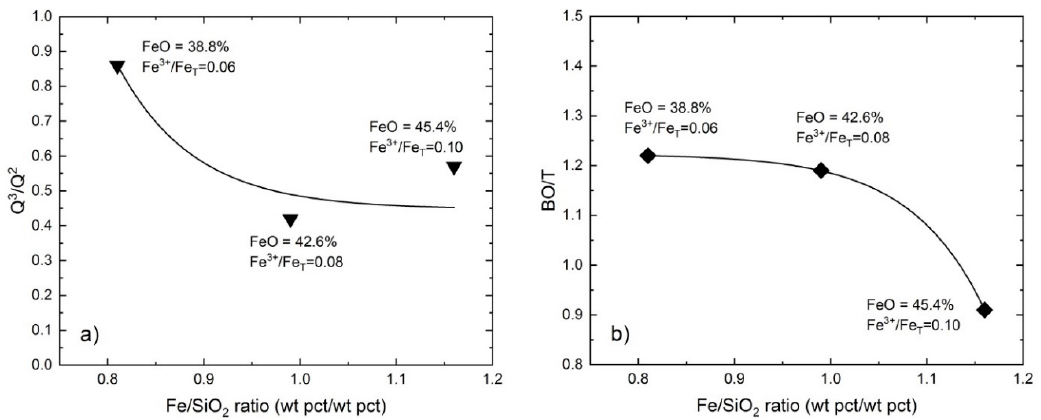
Figure 5. Relationship between Fe/SiO 2 ratio and ( a ) Q 3 /Q 2 ratio and ( b ) bridging oxygen per tetrahedral (BO/T) of FCSM slags ( p O 2 = 10 − 8 atm and T = 1300 °C).